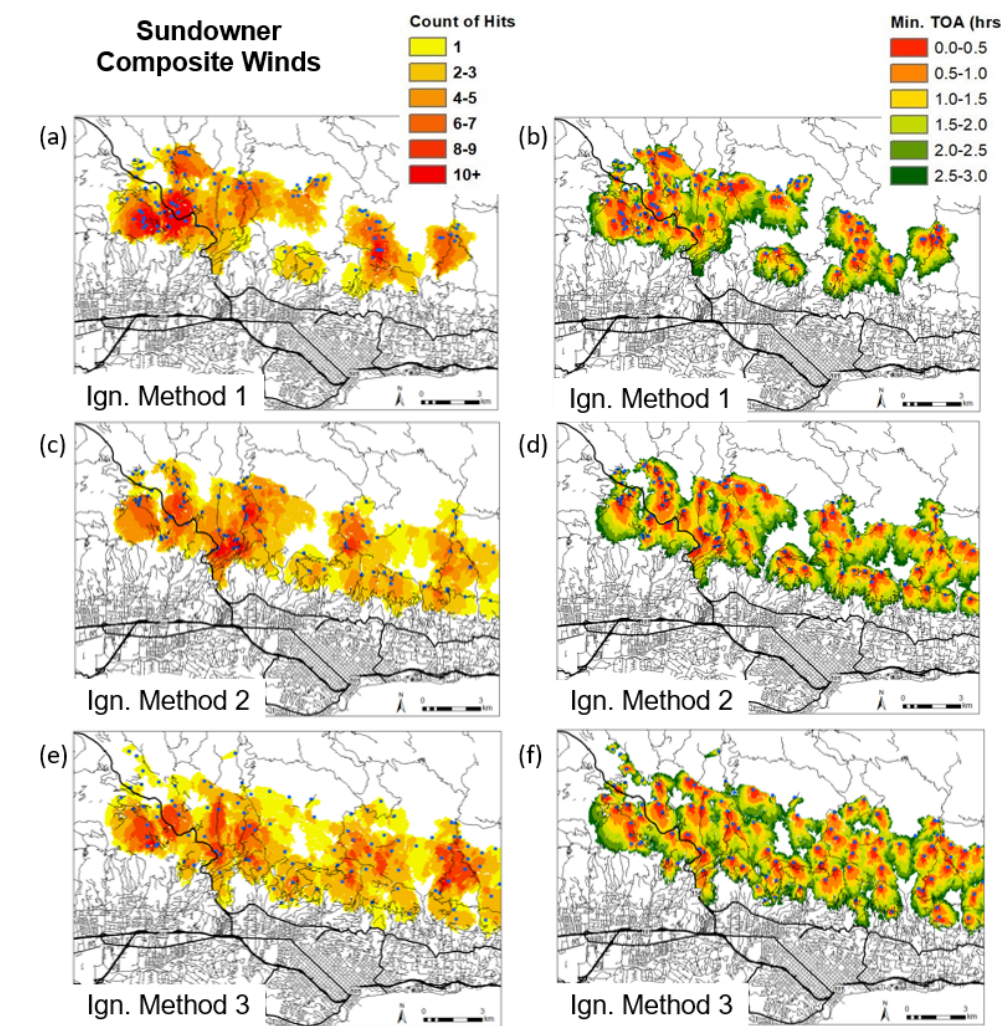
Figure 9. Same as Figure 5, but with wildfire simulations using the Sundowner composite winds. Maps ( a ) and ( b ) show results from ignition method 1, ( c ) and ( d ) show results from ignition method 2, and ( e ) and ( f ) show results from ignition method 3.